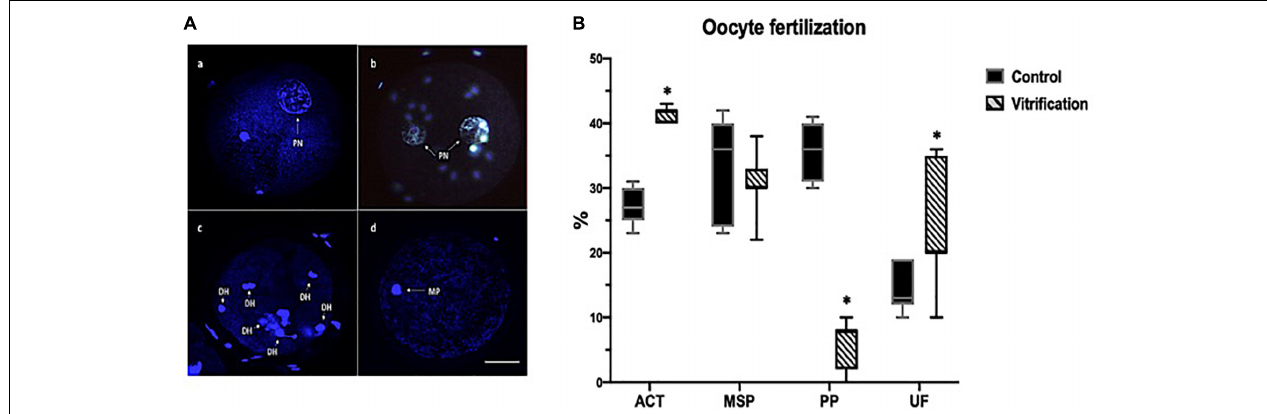
FIGURE 3 | Oocyte in vitro fertilization (IVF) evaluation by Hoechst staining in the control and vitrified groups. (A) Representative images for IVF evaluation criteria: (a) activated oocyte, arrow shows one PN; (b) monospermic zygotes, arrows show two PN; (c) polyspermic oocyte, arrows show decondensed sperm heads, and (d) unfertilized oocytes, arrow shows the metaphase I; pronuclei (PN), decondensed sperm heads (DH), metaphase (MP); (B) percentage of oocyte IVF; activated (ACT), monospermic (MSP), polyspermic (PP), and unfertilized oocytes (UF); the total numbers of evaluated cells in the control and vitrification groups were 126 and 95, respectively; 200 × , scale bar = 30 µ m. ∗ Significant difference vs. control. P < 0.05.